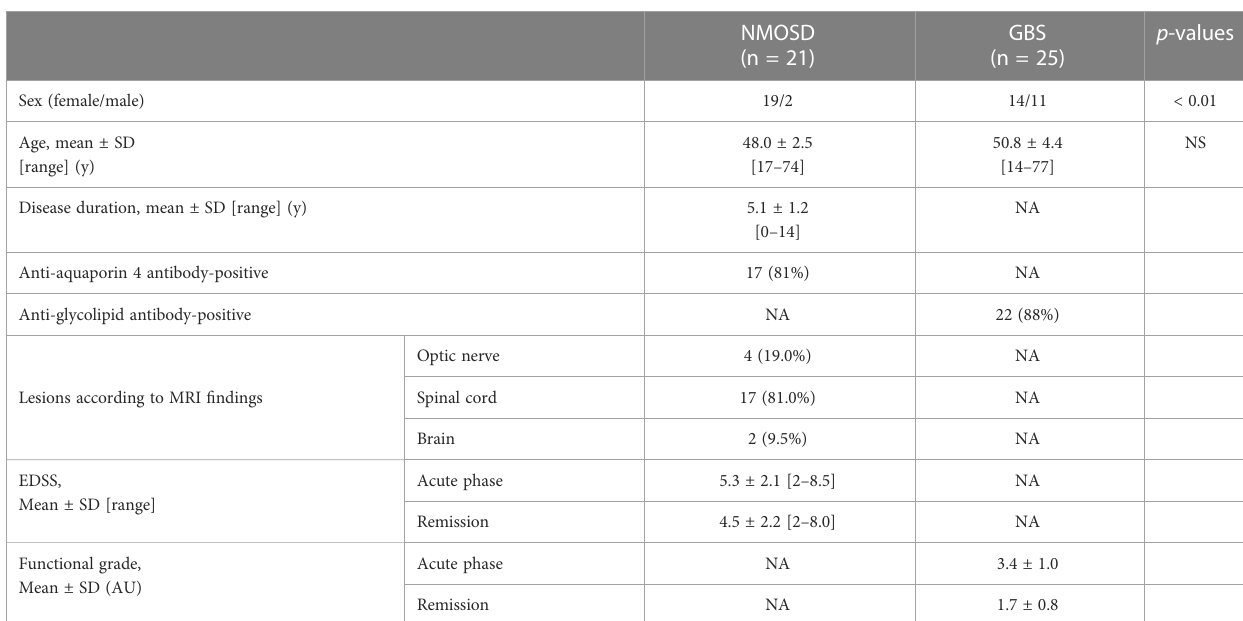
TABLE 1 Patient